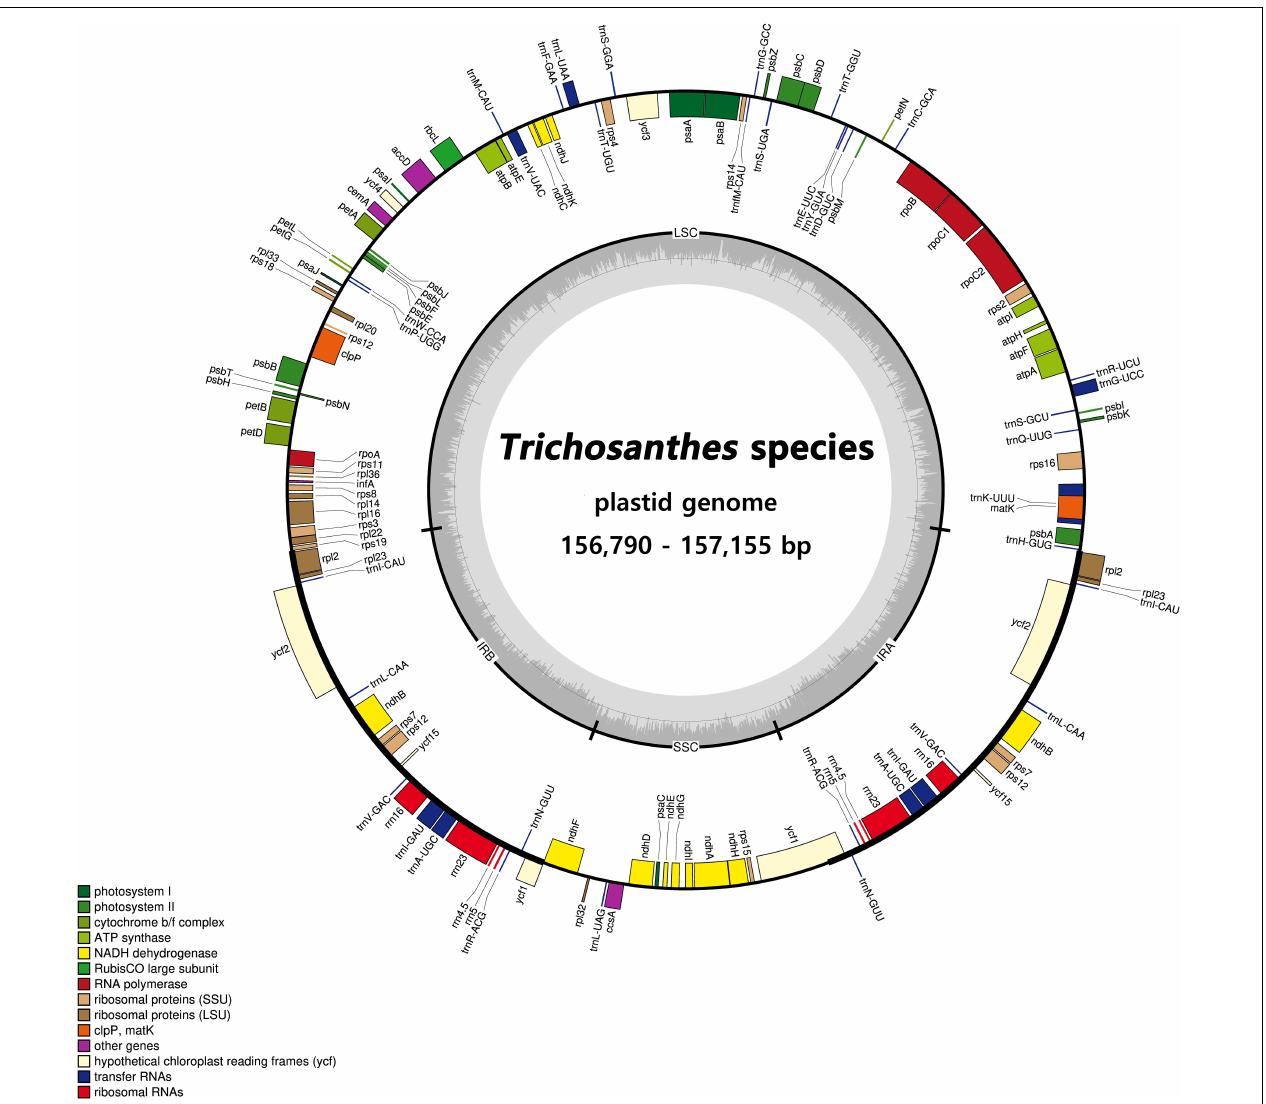
FIGURE 2 | Circular gene map of plastid genomes from Trichosanthes species. Genes drawn inside the circle are transcribed clockwise, and those outside the circle are transcribed counterclockwise. The darker gray in the inner circle represents GC content. The gene map corresponds to the T. kirilowii chloroplast genome.